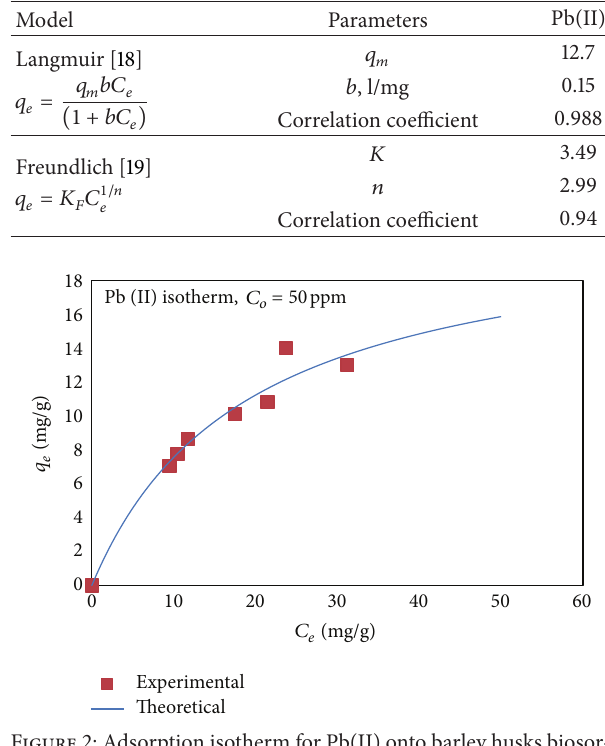
Table 1: Parameters of isotherm for Pb(II) and correlation coeffi- cient for two models.